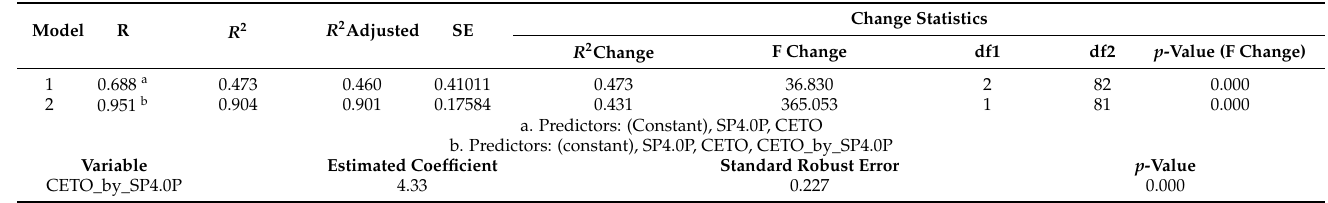
Table 3. Direct and moderated relationships (H1 and